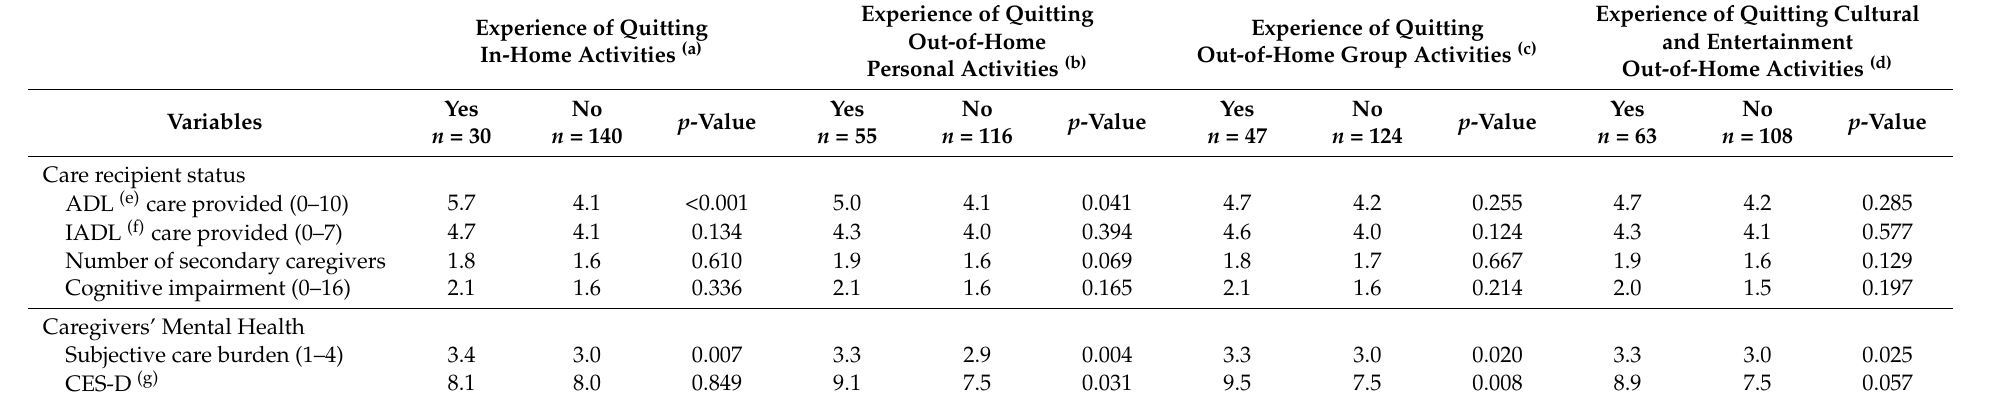
Table 3. Relationship between quitting in leisure activities caused by nursing care, nursing care status, and mental health. Experience of Experience of Quitting In-Home Activities (a)